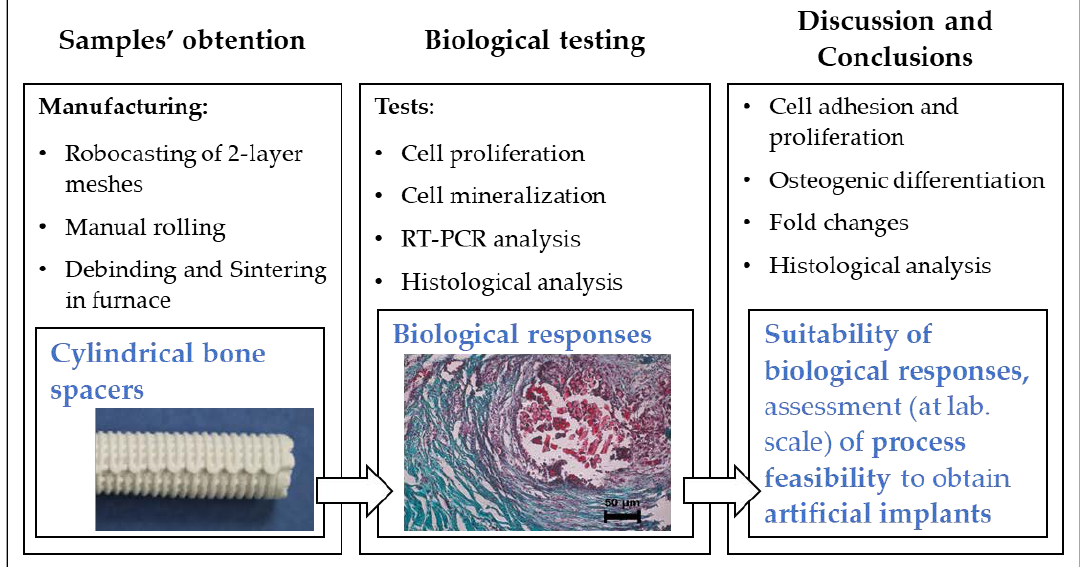
Figure 2. Flow diagram of the study undertaken.